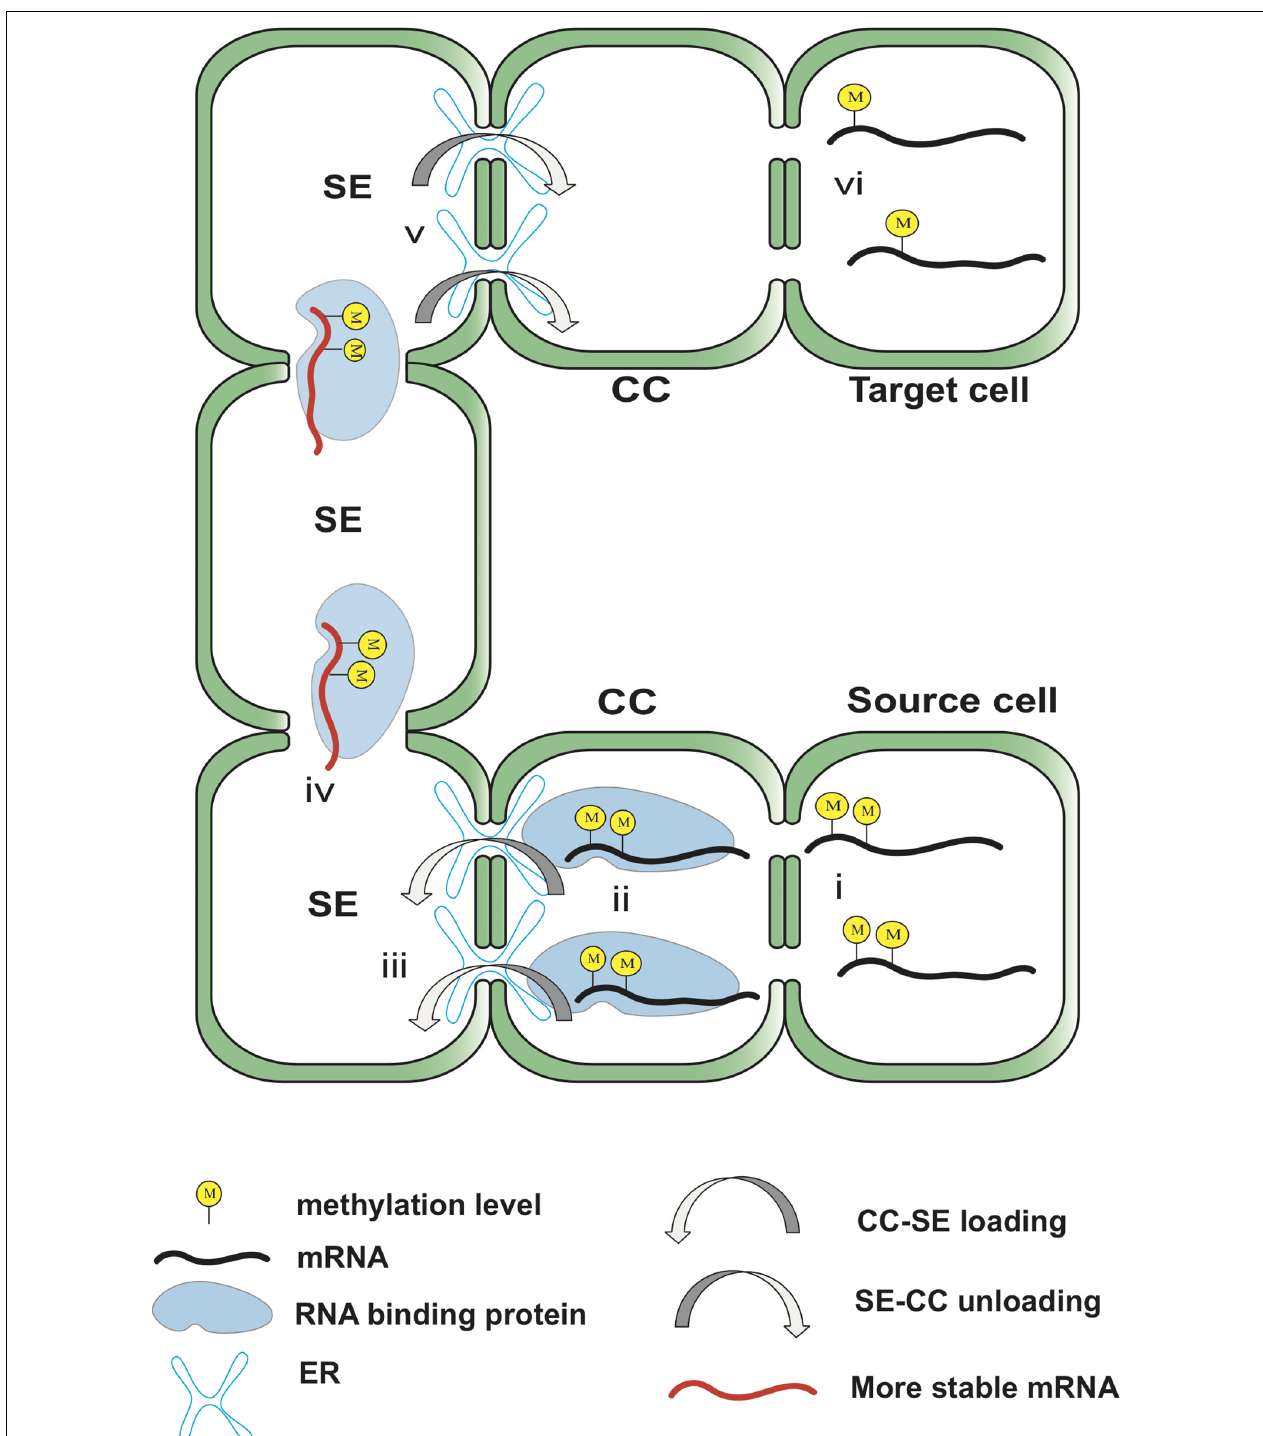
FIGURE 3 | Hypothetical model of the potential involvement of methylation in mRNA transport. The transcribed mRNA is methylated by methyltransferase, which in turn mediates the transport of the mRNA from the nucleus to the cytoplasm. Methylation may reduce the translation ability of the mRNA until it reaches the target cell. RBP recognizes the motif near the methylation site to form an RNA-protein complex. Methylation is involved in regulating the size-exclusion limit of PD to carry out STS loading of mRNA and stabilize mRNA and its TLS in SE. Methylation is involved in identifying unloading locations and completing sieve element unloading of mRNA near the target cell. After reaching the target cell, mRNA reduces the methylation level under the action of demethylase and restores translation ability. The locations of yellow circles in the figure do not indicate the actual methylation sites, but the number of them indicates the level of methylation.